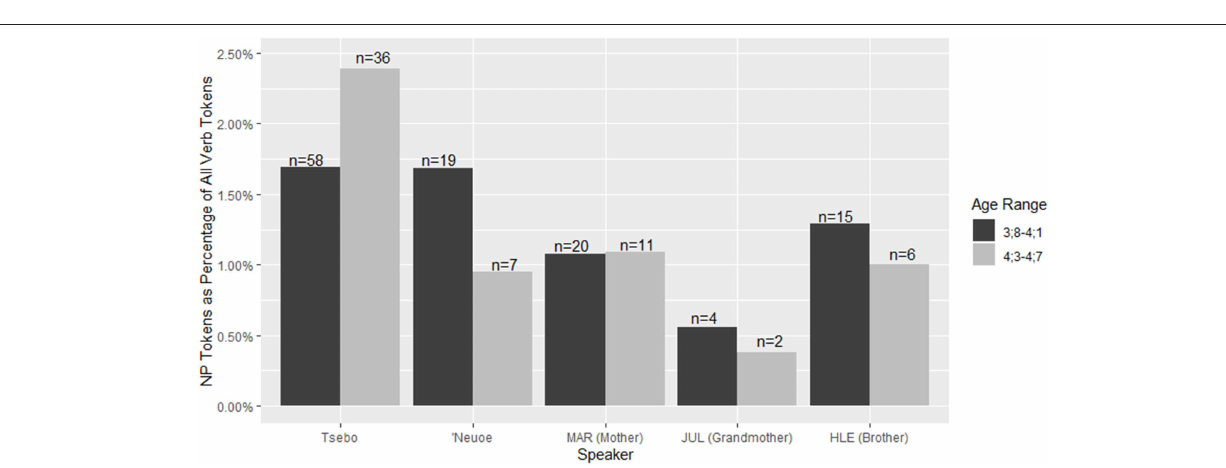
Frontiers in Communication |